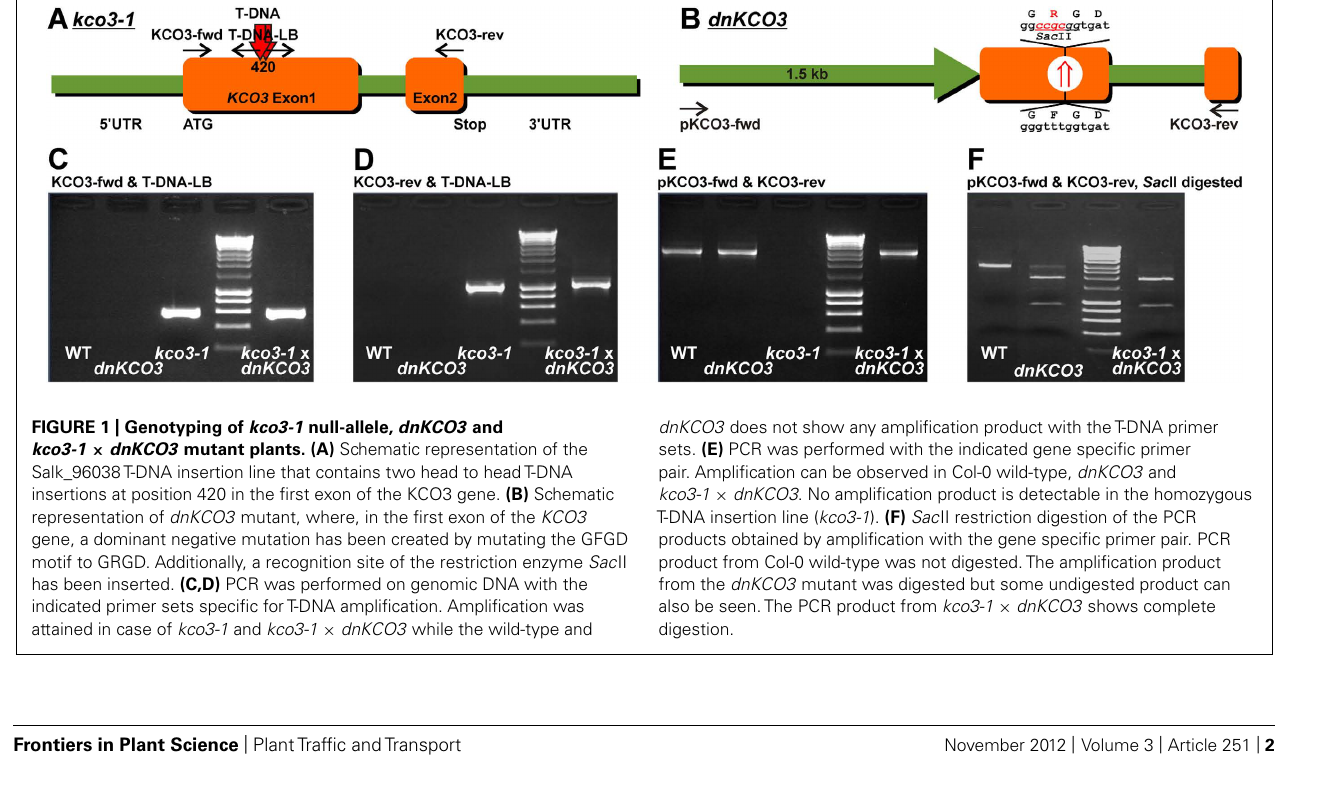
FIGURE 1 | Genotyping of kco3-1 null-allele, dnKCO3 and kco3-1 × dnKCO3 mutant plants. (A) Schematic representation of the Salk_96038T-DNA insertion line that contains two head to headT-DNA insertions at position 420 in the first exon of the KCO3 gene. (B) Schematic representation of dnKCO3 mutant, where, in the first exon of the KCO3 gene, a dominant negative mutation has been created by mutating the GFGD motif to GRGD. Additionally, a recognition site of the restriction enzyme Sac II has been inserted. (C,D) PCR was performed on genomic DNA with the indicated primer sets specific forT-DNA amplification. Amplification was attained in case of kco3-1 and kco3-1 × dnKCO3 while the wild-type and